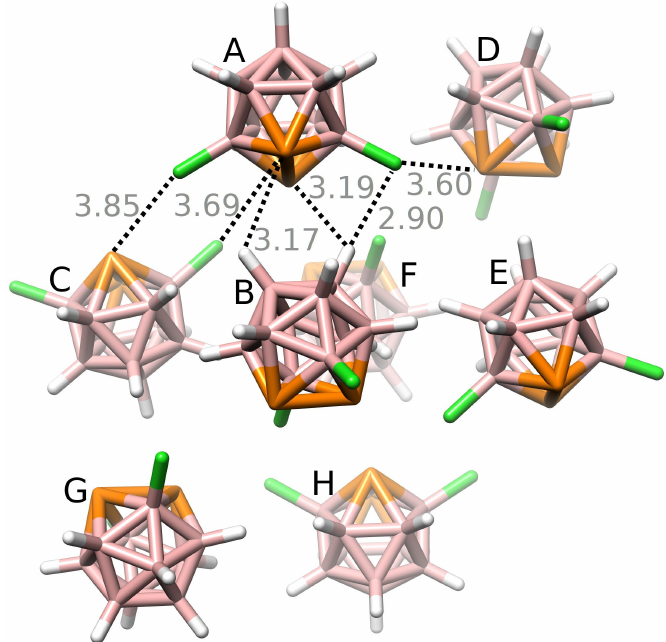
Figure 3. The crystal packing of 3,6-Cl 2 -closo-1,2-P 2 B 10 H 8 ( 1 ). Distances in Å. The color gray is used for distances larger than Σ r vdW . The positions of H atoms were optimized at the DFT-D3/BLYP/DZVP level.